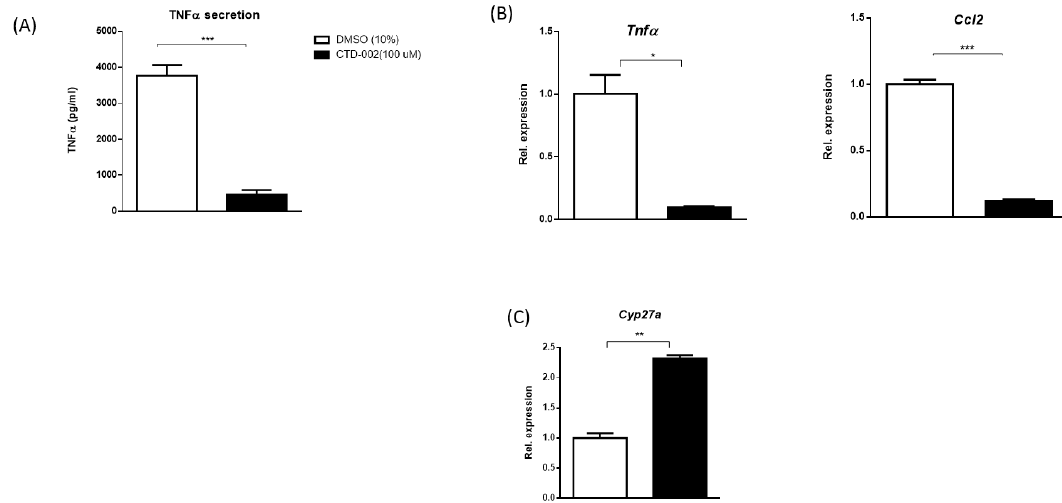
ff ects of CTD-002 on inflammation and cholesterol metabolism in bone marrow-derived